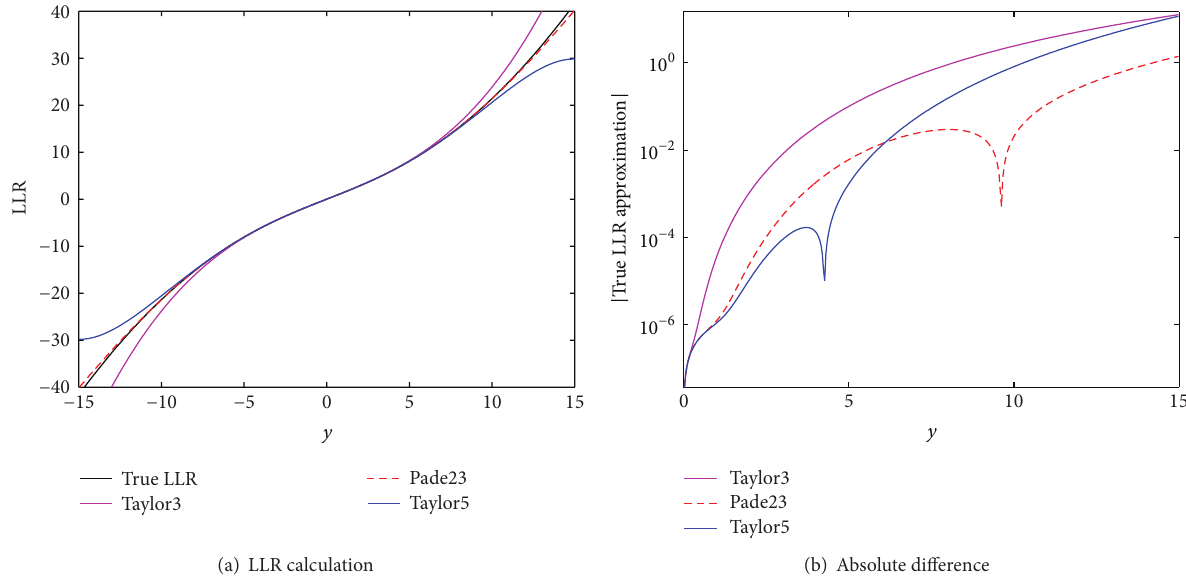
Figure 3: Comparison of true LLR and approximated LLRs (Taylor3, Taylor5, and Pade23) for the uncorrelated flat Rayleigh fading channel with unknown CSI and 𝜎 = 1.0264 . Pade23 also gives almost the same values as the true